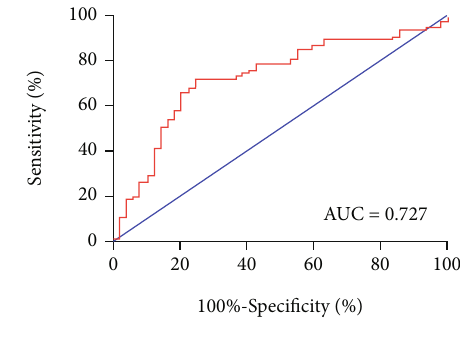
Figure 3: ROC curve of SII for recurrence prediction.